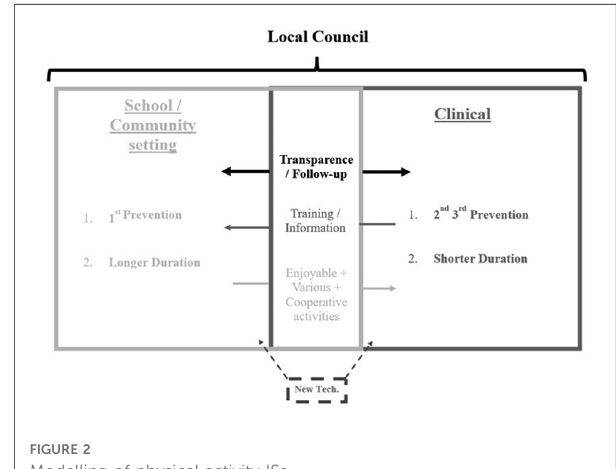
FIGURE 2 Modelling of physical activity